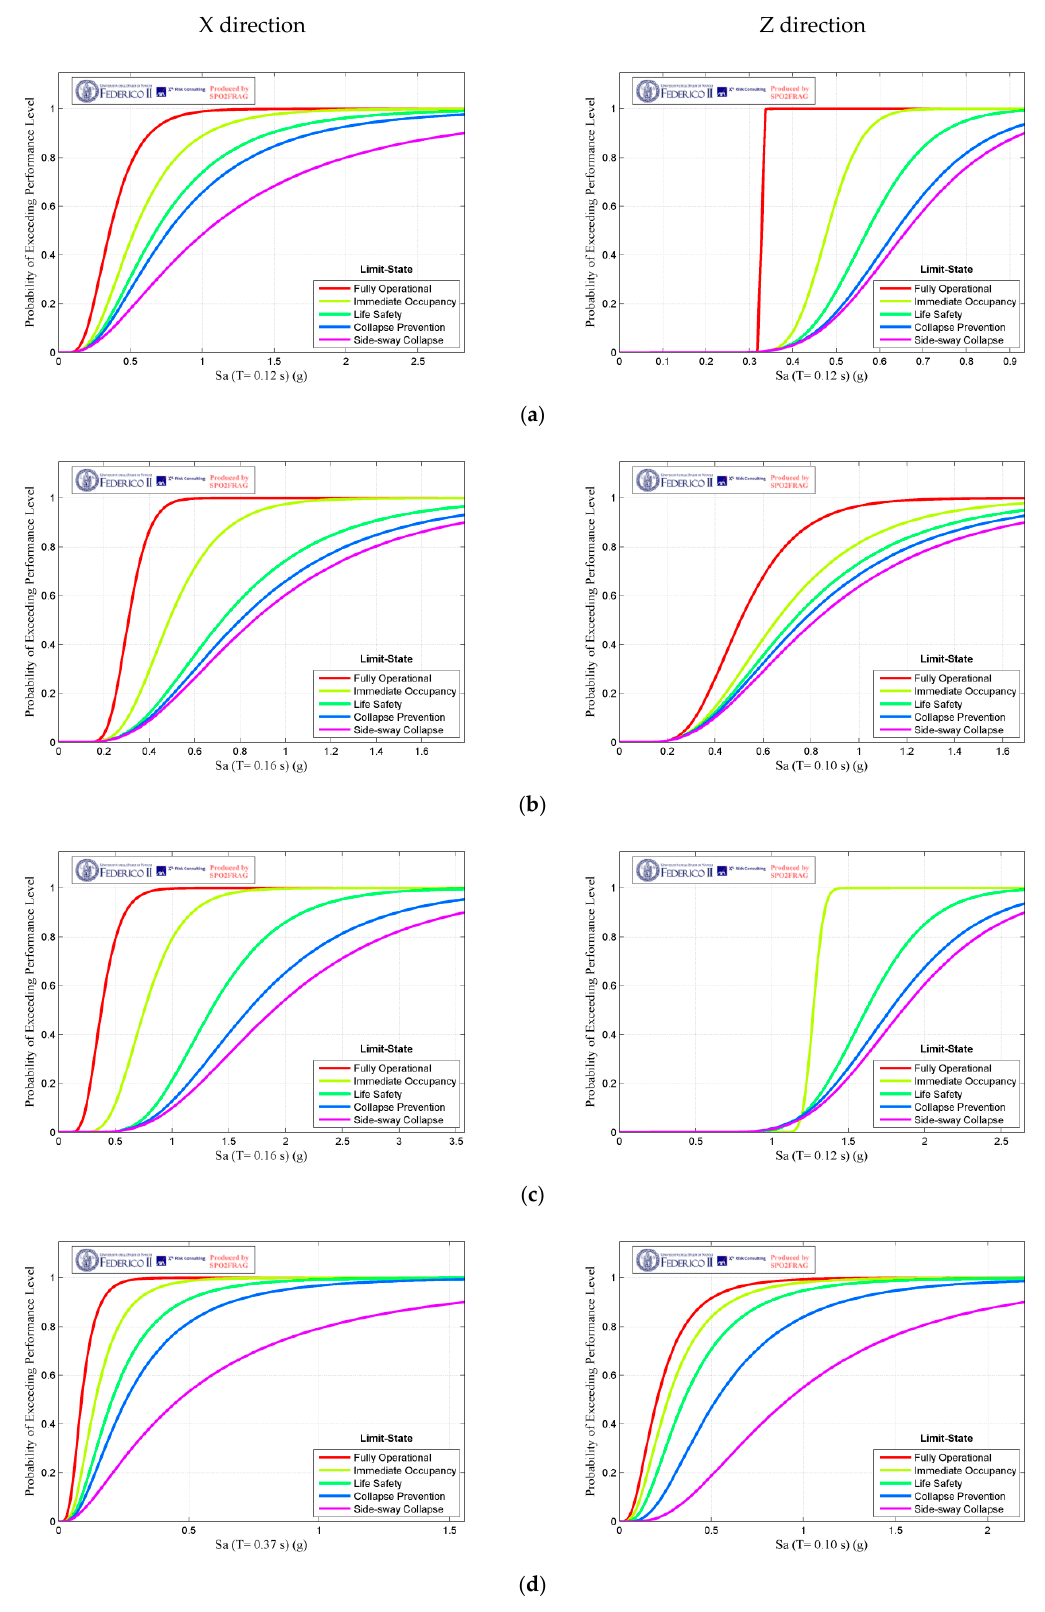
Figure 10. Push-over-based fragility curves of the URM models: ( a ) Type-1; ( b ) Type-2; ( c ) Type-3; ( d )